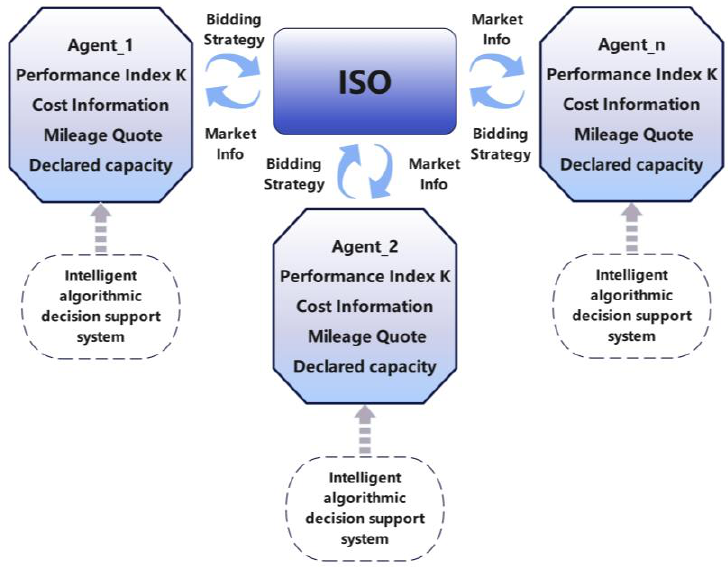
Figure 3. Schematic diagram of the multi-agent-based frequency regulation market model.